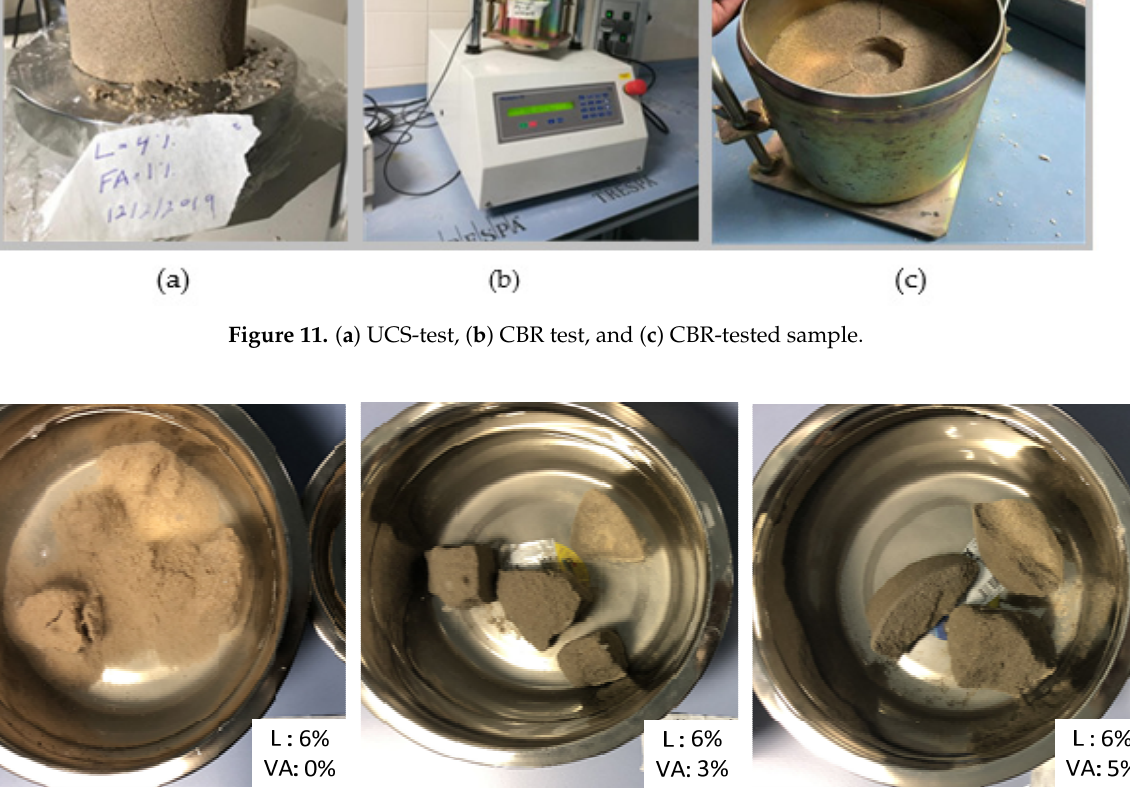
Figure 12. Samples of stabilized dune sand soaked in water. ( a ) L: 6%, VA: 0%, ( b ) L: 6%, VA: 3%, and ( c ) L: 6%, VA: 5%.